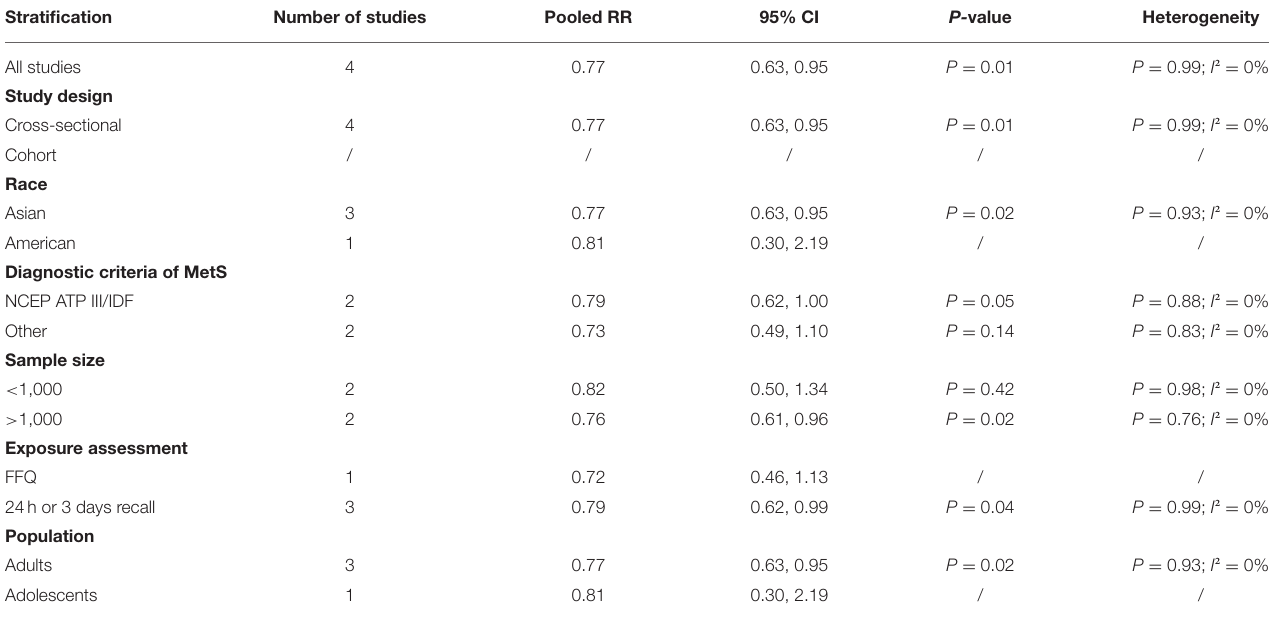
TABLE 4 | Subgroup analysis of MetS for the highest vs. lowest dietary selenium level